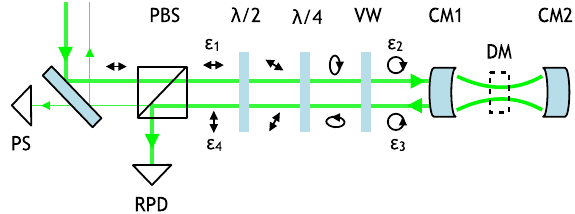
FIG. 4. Scheme for maximizing the circular polarization at the cavity. Laser light entering the system passes through a PBS, half- wave plate ( λ = 2 ), quarter-wave plate ( λ = 4 ), and vacuum window (VW) before it is either reflected off the cavity entrance mirror (CM1) or becomes resonant in the cavity. Note that in this figure, the element VW also includes three steering mirrors, which are incorporated in the model but left out of the figure for